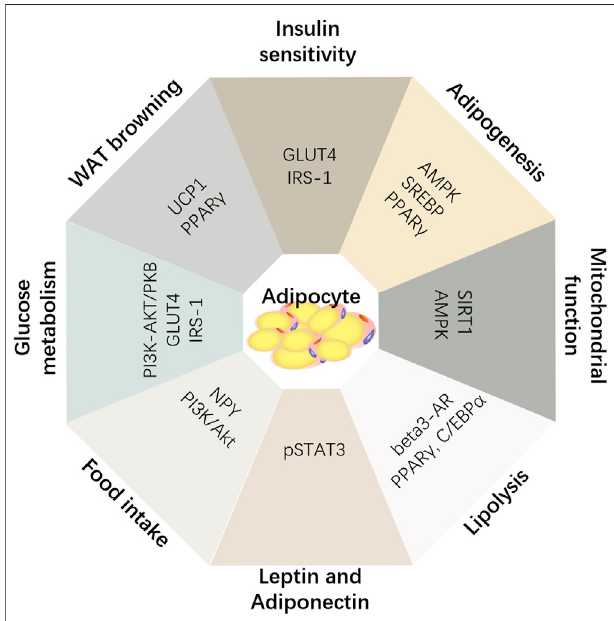
FIGURE 2 | Summary of anti-obesity mechanism of